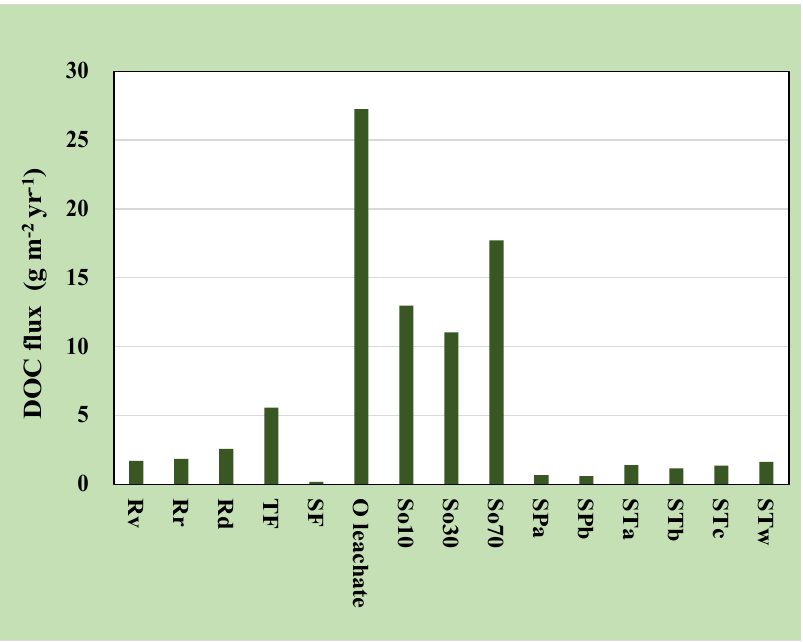
Figure 5. Annual DOC flux among all sample types at the YMS. See Figure 1 for the meaning of the